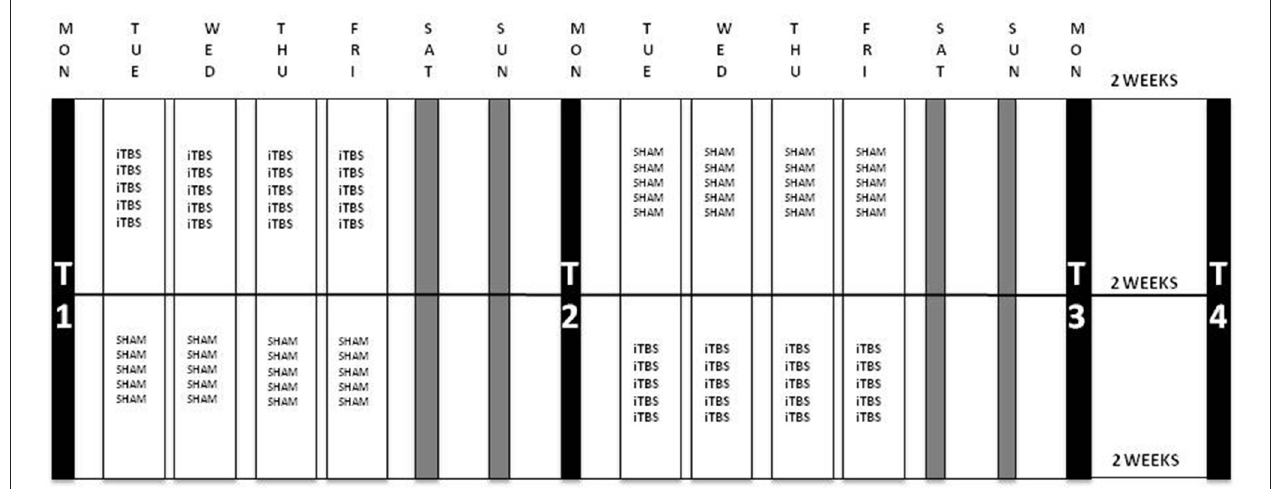
FIGURE 1 | Flowchart of the iTBS-sham-controlled cross-over protocol. Patients were randomized to two groups: group A ( n = 22) received iTBS during the first week and sham in the second week and group B ( n = 24) was administered sham stimulation during the first and iTBS in the second week. Stimulation parameters: 110% resting MT (rMT), 1620 pulses per session in 54 bursts of three with a train duration of 2 s and an intertrain interval of 8 s; five sessions per day during 4 days per week. Evaluations were carried out at four time-points: at baseline (T1), after the first week of stimulation (T2), after the second week of stimulation (T3) and 2 weeks after the last stimulation, i.e., 1 month after baseline (T4). iTBS, intermittent Theta Burst Stimulation; MT, Motor Threshold.